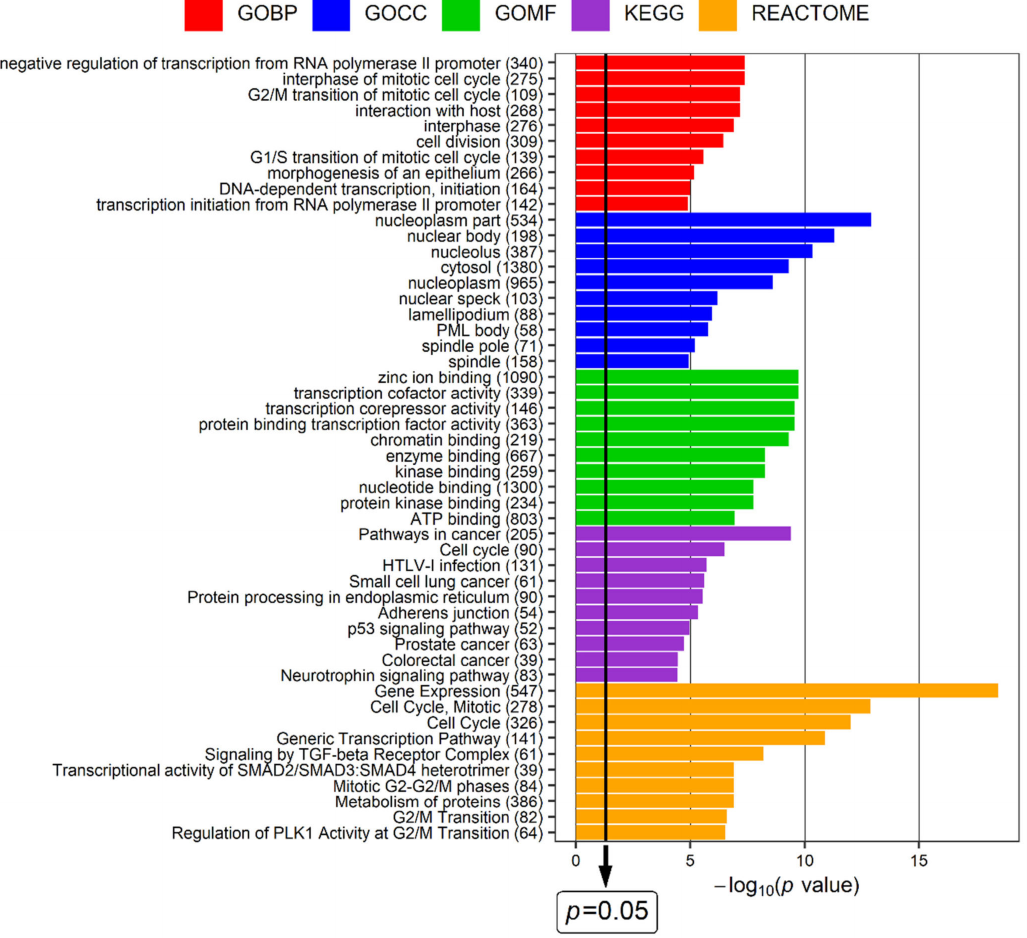
Figure 4. Results of the functional analysis performed using the miRNet 2.0 online platform for genes regulated by 24 miRNAs associated with the studied indicators of LEAD. Up to the top 10